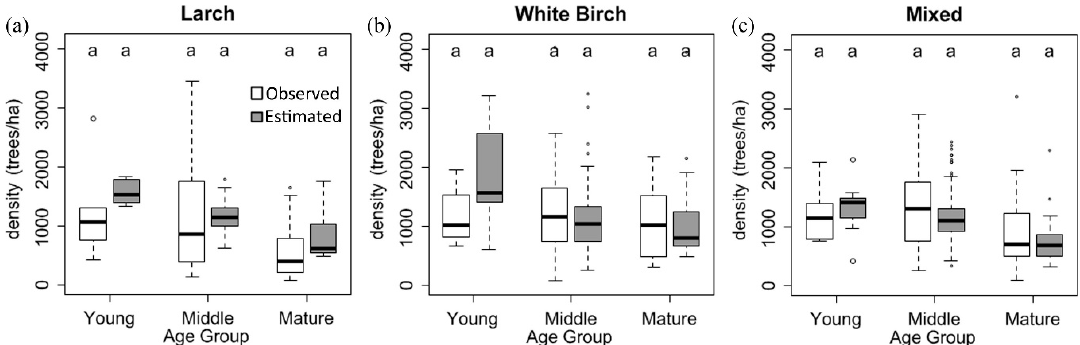
Figure 5. Boxplots of observed vs. predicted tree density of three main forest types (Larch forests ( a ), White birch forests ( b ) and Mixed forests ( c )) with similar environment ( p > 0.05). Observed tree density was calculated from the inventory plot data in 2011. Estimated tree density was calculated from the estimated tree-lists in 2000s. The same letter “a” indicated that there was no obvious difference between observed and estimated tree density.